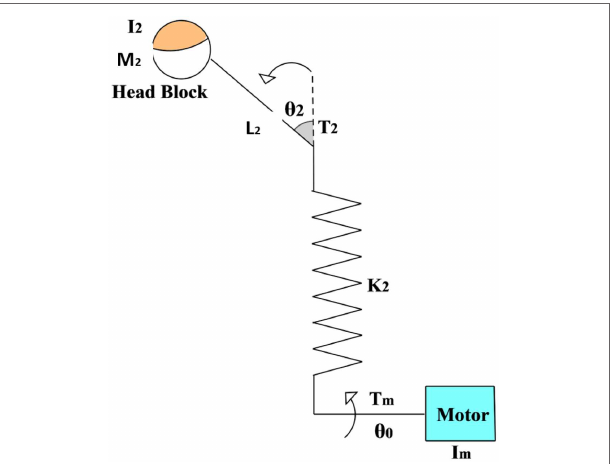
FIGURE 3 | Adopted model for pitch rotation